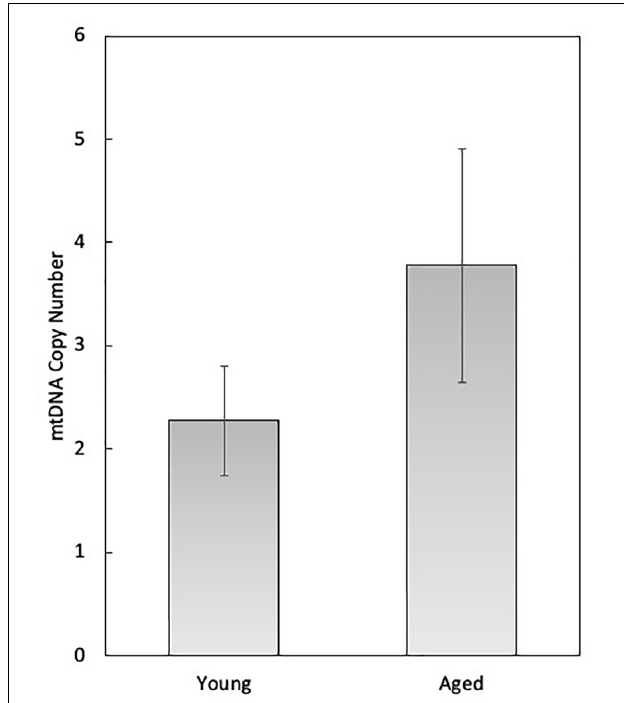
FIGURE 1 | Single-molecule PCR (smPCR) analysis of oocyte mitochondria collected from 6-week-old (young) and 12-month-old (aged) C57BL/6 mice for the determination of mtDNA copy number on a per-organelle basis. The average mtDNA copy number of the young mouse oocyte mitochondria was 2.27 (SEM = 0.53; n = 22), and of aged mice was 3.27 (SEM = 1.13, n = 27).